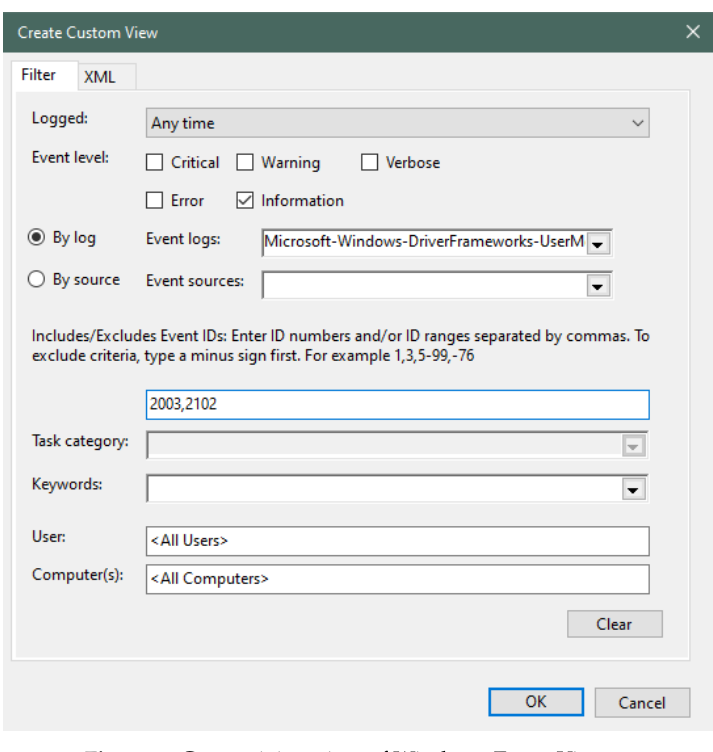
Figure 9. Customizing view of Windows Event Viewer.